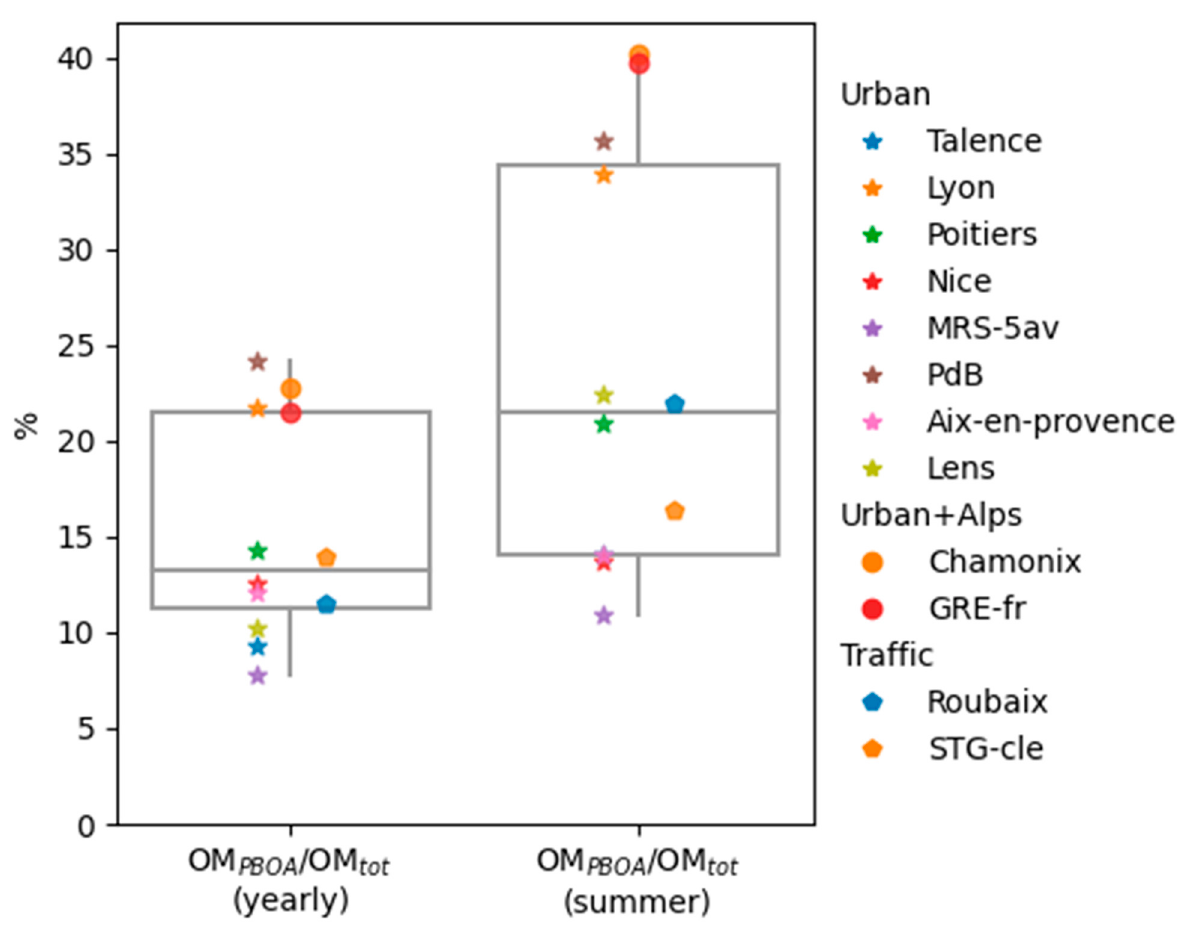
Figure 14. Annual mean and summer-averaged contribution of PBOA to total OM concentrations at various French urban sites.